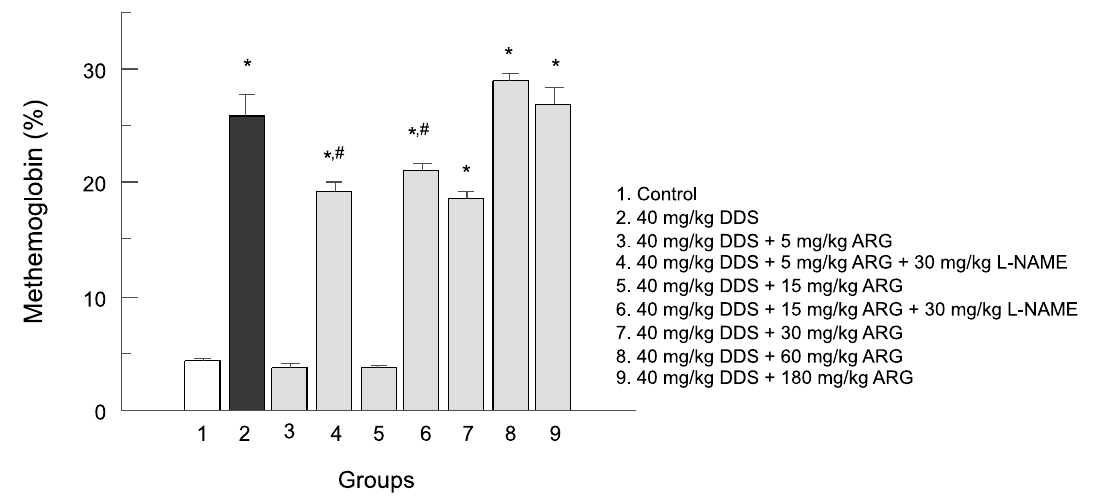
FIGURE 2 - Effect of multiple dose L-arginine (ARG) on methemoglobin level (%). Animals were treated with saline or ARG at 5, 15, 30, 60 and 180 mg/kg doses (p.o., gavage) or simultaneous gavage of ARG at 5 and 15 mg/kg doses and 30 mg/kg L-NAME for five days. On the fifth day, rats were treated with 40 mg/kg DDS (i.p.) 2 hours after ARG administration. Data expressed as means ± standard deviation. *p < 0.001 compared to the Control group; # p<0.001 when groups treated with L-NAME are compared to the respective group without